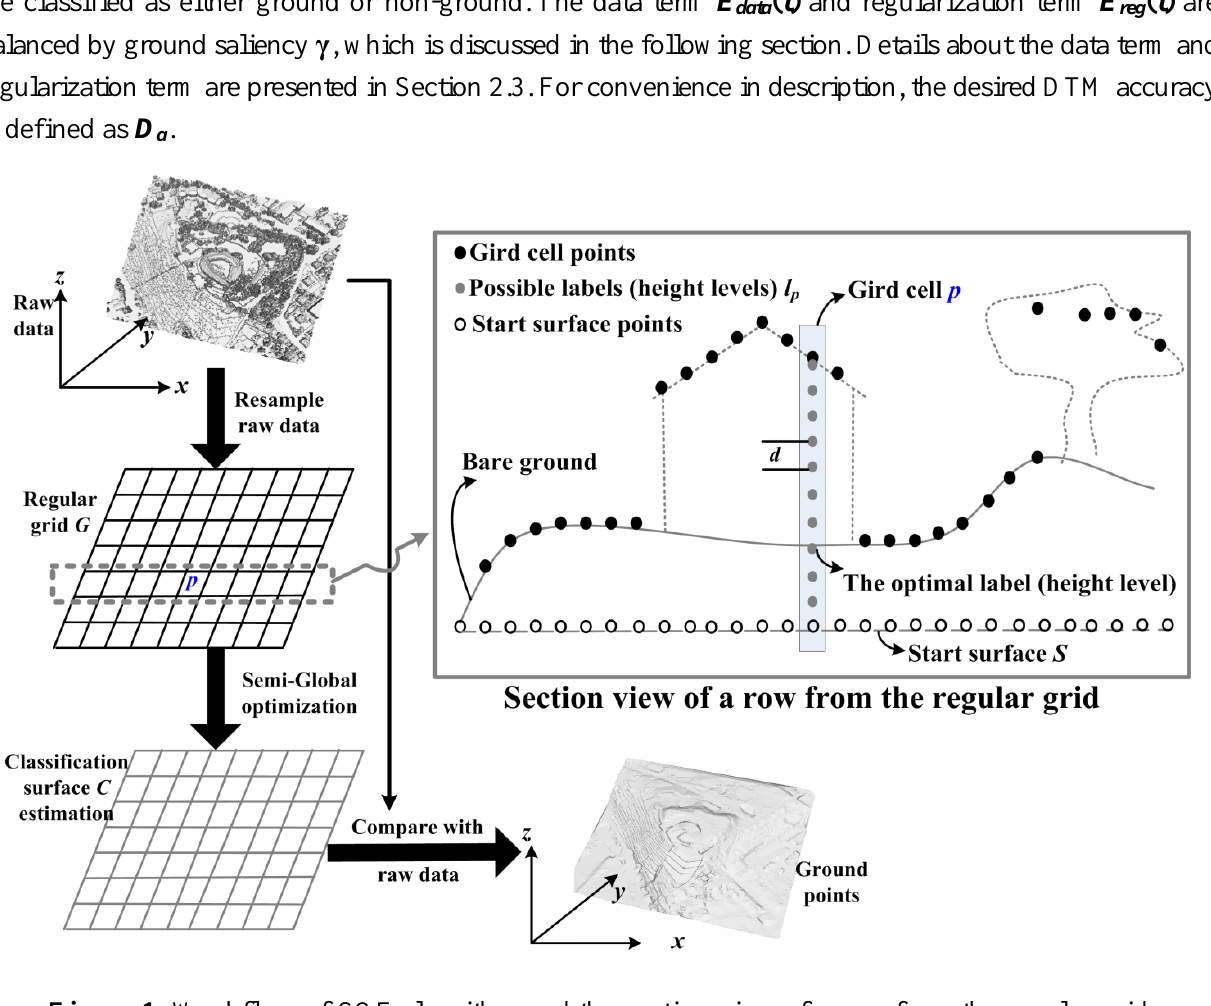
Figure 1. Workflow of SGF algorithm and the section view of a row from the regular grid (to avoid clutter, we draw possible labels for only one grid